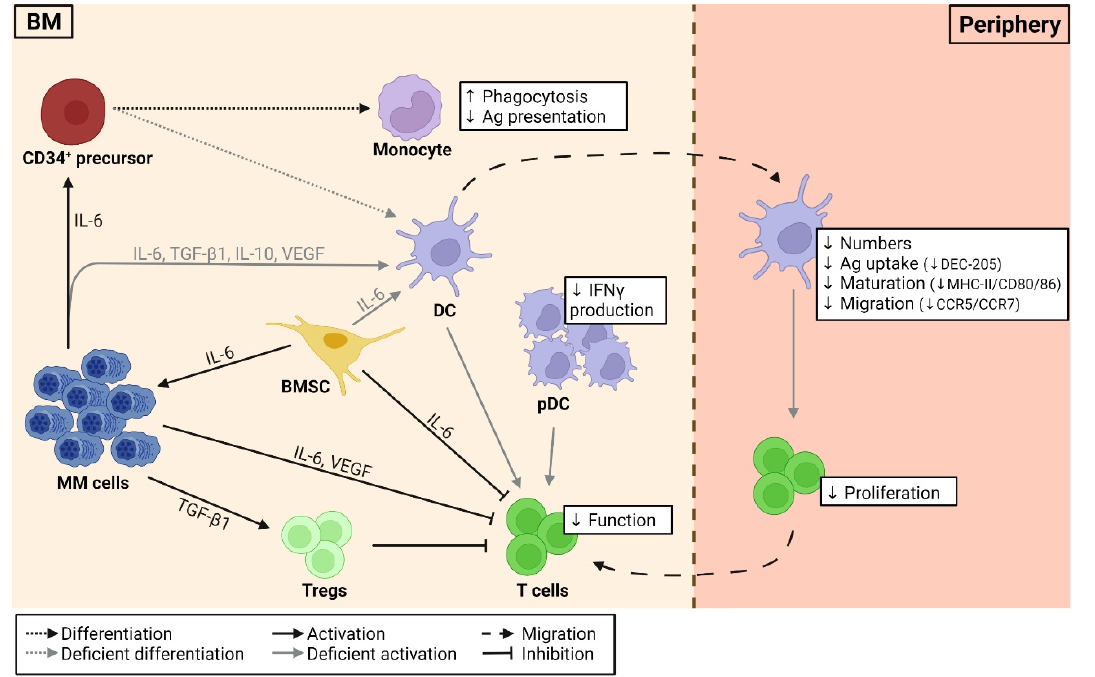
Figure 2. Schematic overview of the factors engaged in DC deficiencies in MM. DC differentiation, maturation, and activation are hampered by tumor microenvironmental factors. Tumor-derived cytokines, such as IL-6, promote CD34 + precursor cell differentiation into monocytic cells instead of DC progenitors, whereas TGF- β 1, VEGF, and IL-6/-10 are found to be responsible for impaired DC maturation (decreased MHC-II/CD40/CD80/86) and function (decreased CCR5/CCR7/DEC-205). Impaired DCs lack efficient T cell activation. Tumor-derived factors, such as IL-6 and VEGF, can directly inhibit T cell function, whereas TGF- β 1 favors the differentiation and expansion of Tregs, which on their terms suppress T cell function. pDCs, found in MM patients, show defective interferon (IFN)- γ production and accumulate in the BM niche, exerting immunosuppressive and tumor-promoting properties. The tumor microenvironment promotes MM cells survival through, for instance, the secretion of IL-6 by BMSCs. DC, dendritic cell; MM, multiple myeloma; BM, bone marrow; Ag, antigen; BMSCs, BM stromal cells; pDC, plasmacytoid DCs; Tregs, regulatory T cells; IL-6, interleukin 6; TGF- β 1, transforming growth factor- β 1; VEGF, vascular endothelial growth factor.